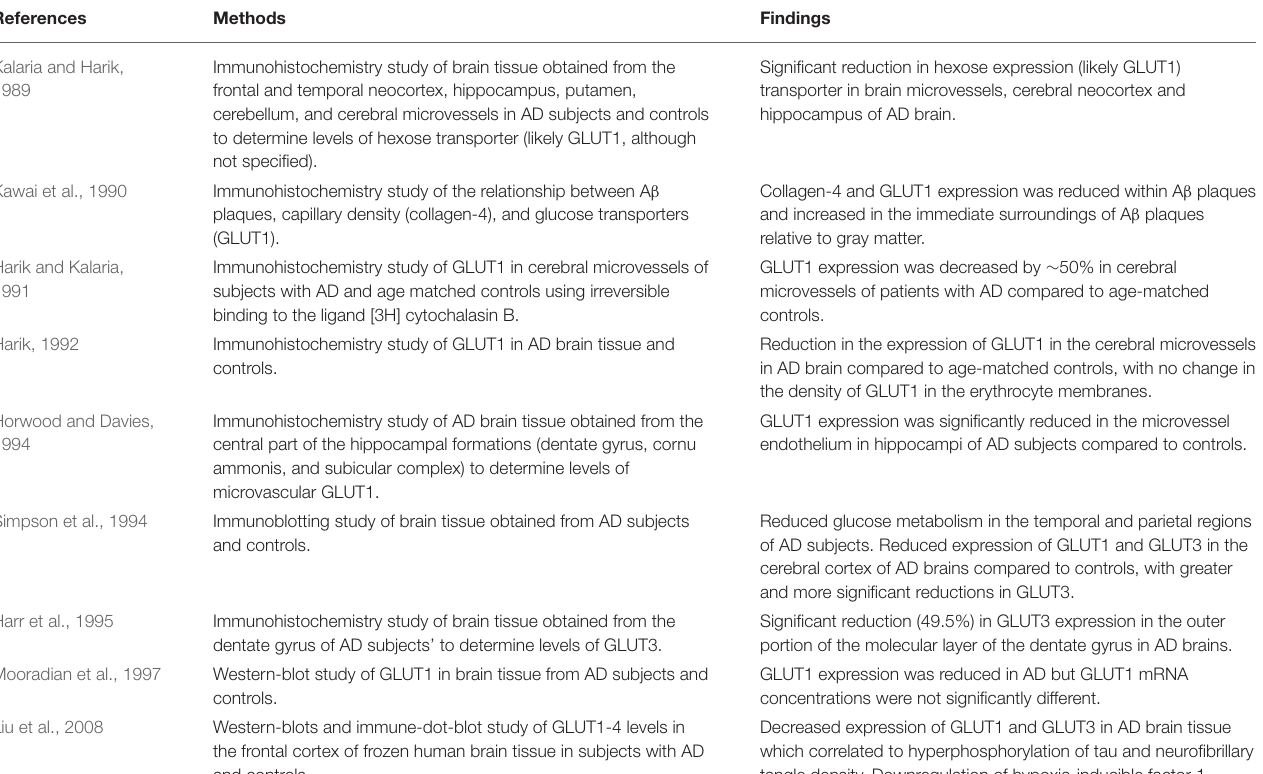
TABLE 2 | A summary of results from human post-mortem and tracer